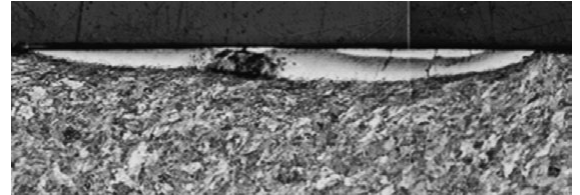
Fig. 1. White Etching Layer (WEL) on the surface of the rail (Wang 2002) – Nital, magn.